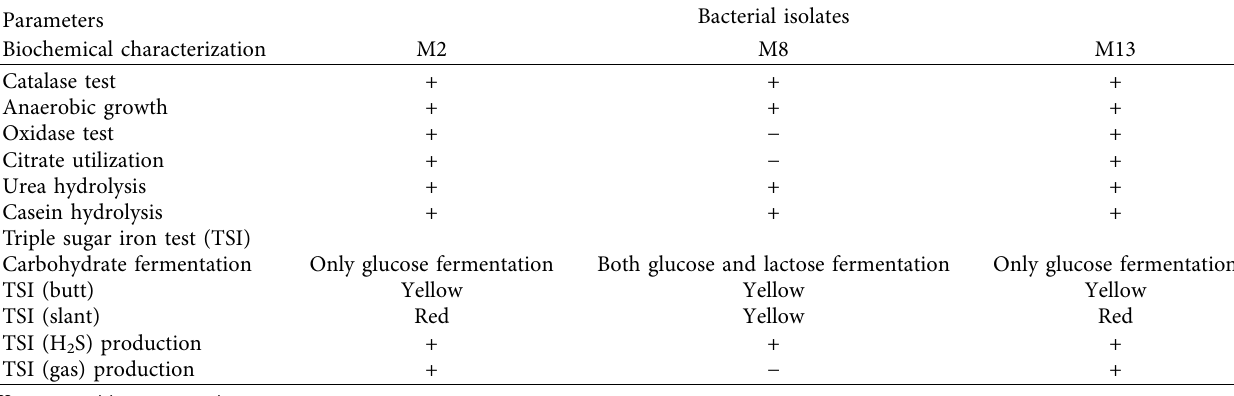
Table 3: Biochemical characterization of bacterial isolates.